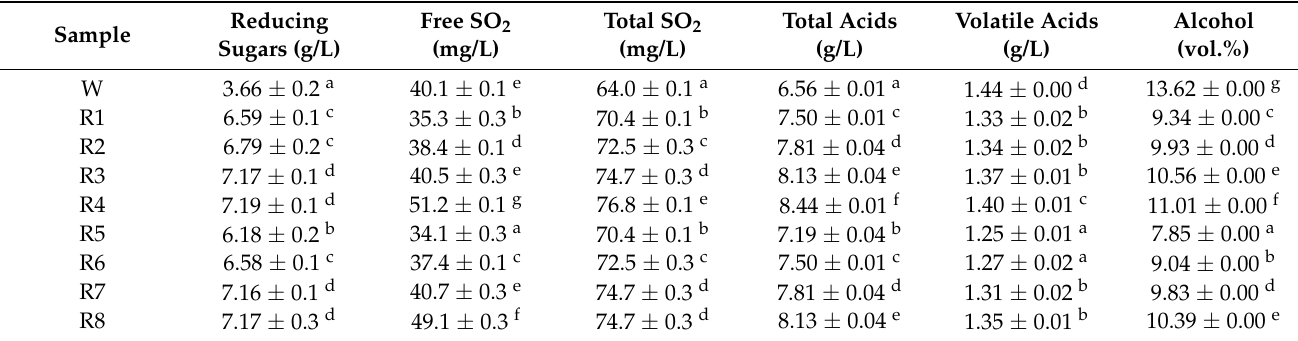
Table 1. Chemical composition of initial Cabernet Sauvignon wine variety and reverse osmosis retentates at 2.5, 3.5, 4.5 and 5.5 MPa with cooling (C) and without cooling (WC).